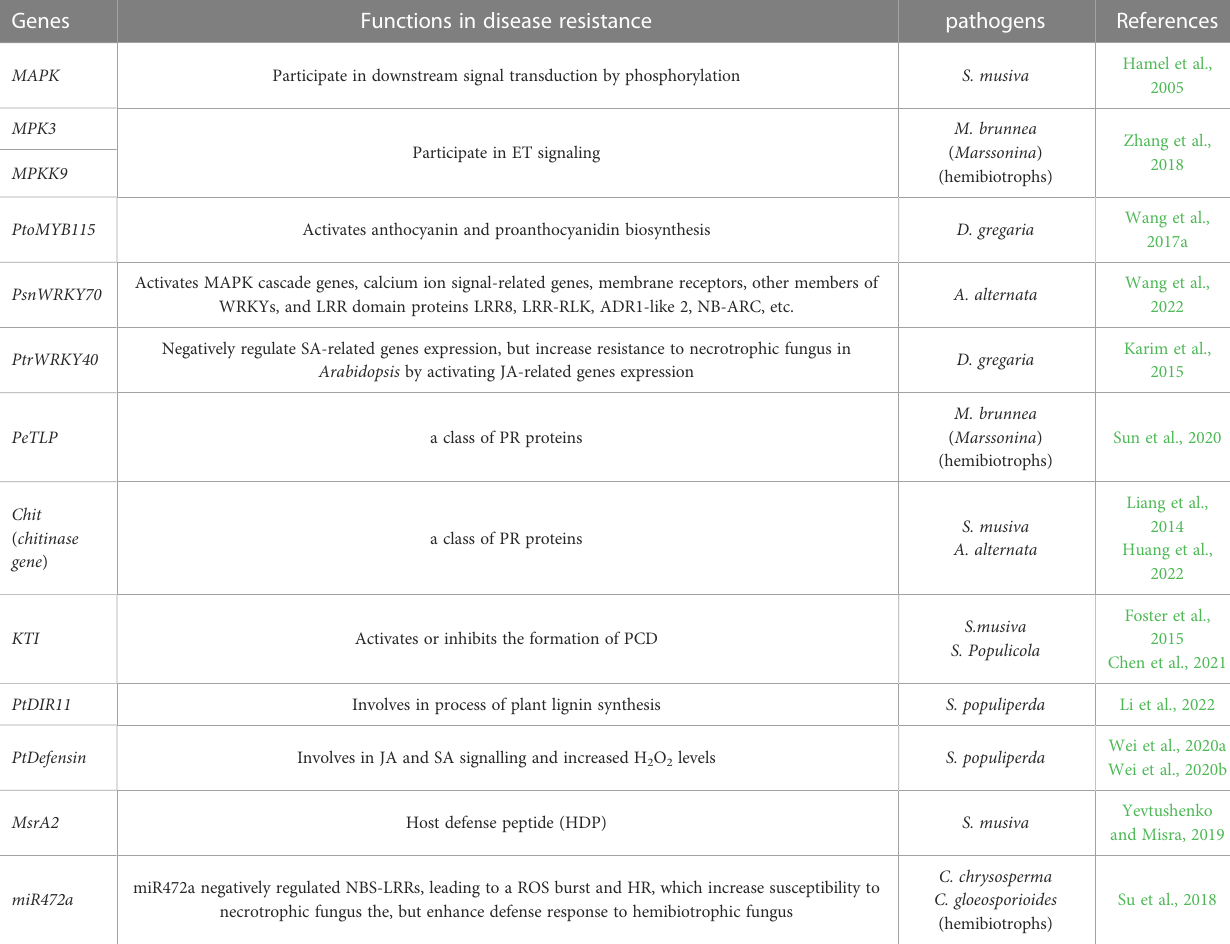
TABLE 2 The genes involved in poplars defense response to necrotrophic or hemibiotrophic